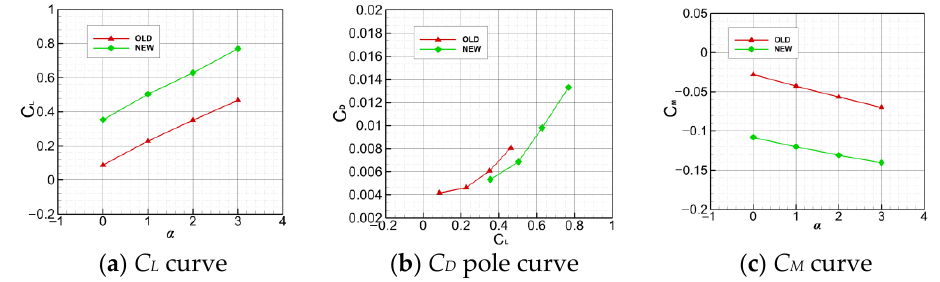
Figure 27. Comparison of the aerodynamic coefficients of the central experimental wing.